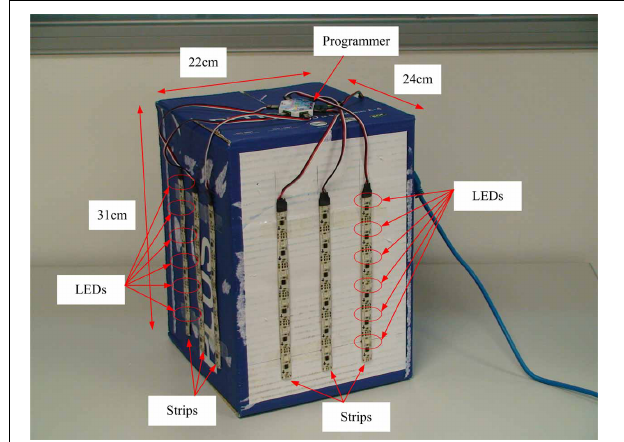
FIGURE 3 | Temporal match. Two events can be considered as candidates to match if they are generated within a certain time interval δ t